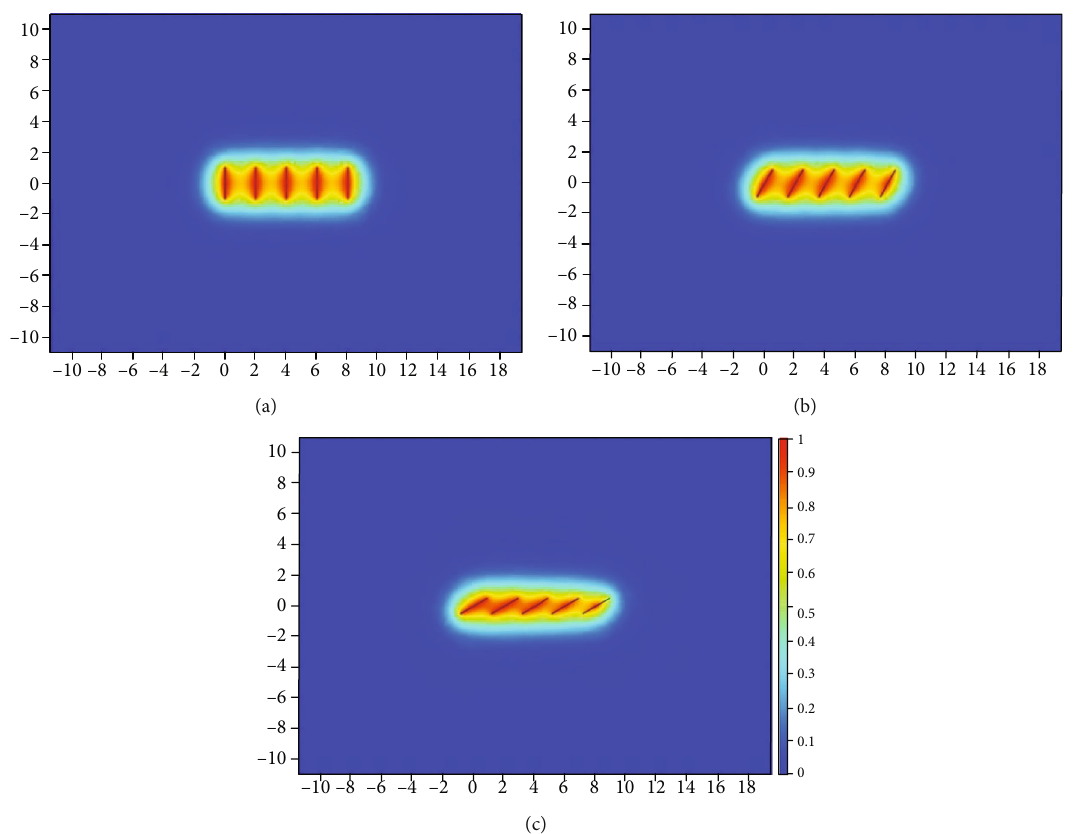
Figure 8: In fl uence of fracture dip angle θ on production: (a) case 1 dip angle θ = 90 ° ; (b) case 2 dip angle θ = 60 ° ; (c) case 3 dip angle θ = 30 ° . 0.0010.010.110100